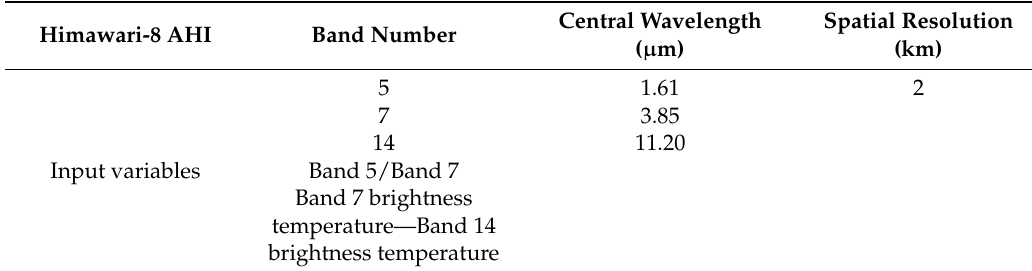
Table 1. Himawari-8 AHI-derived input variables used in the threshold-based